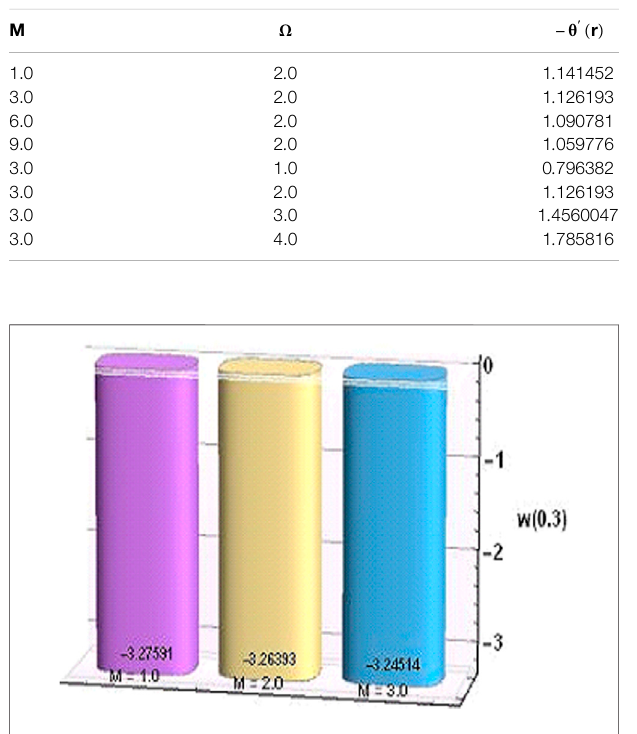
FIGURE 19 | Velocity for the magnetic parameter at r (cid:1) 0.3.